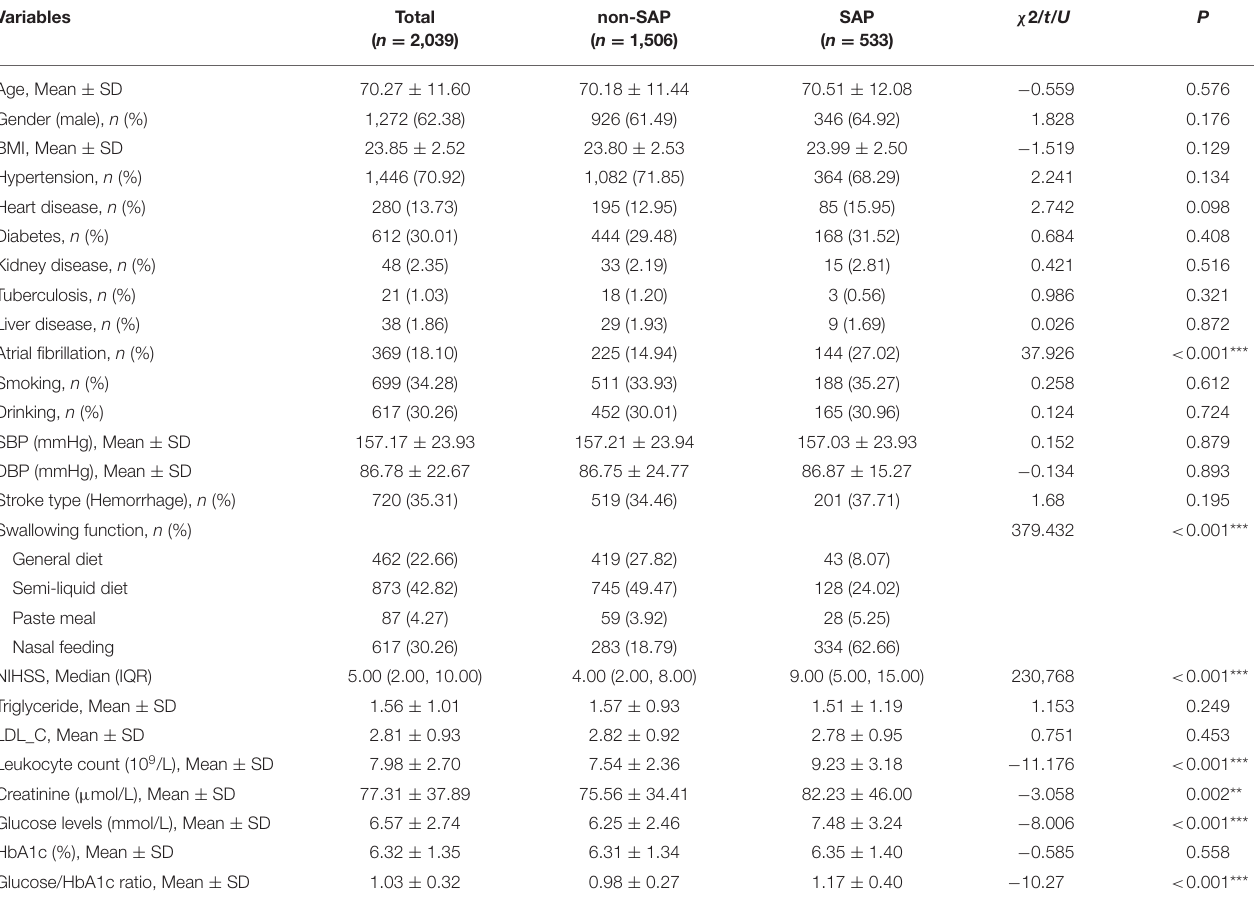
TABLE 1 | Comparison of characteristics between non-SAP and SAP groups in the total patients. Variables Total ( n =